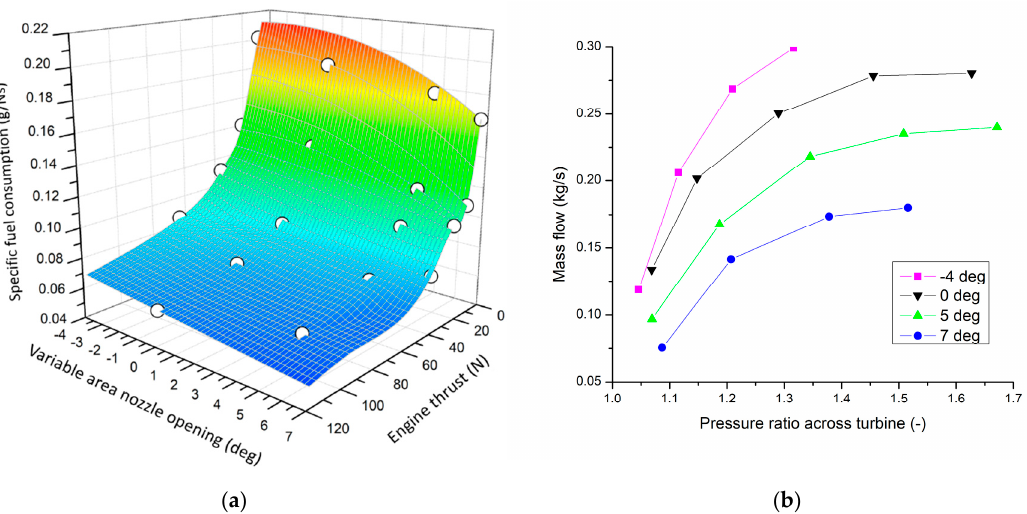
Figure 14. Turbine variable area nozzle impact on: ( a ) specific fuel consumption and engine thrust; ( b ) mass flow and turbine pressure ratio.